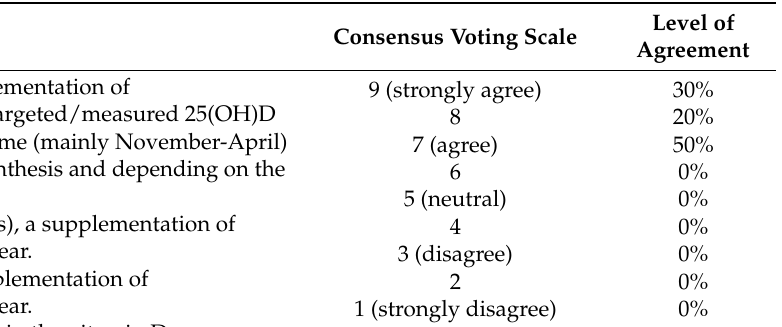
Table 5. Statement regarding prevention of vitamin D deficiency in